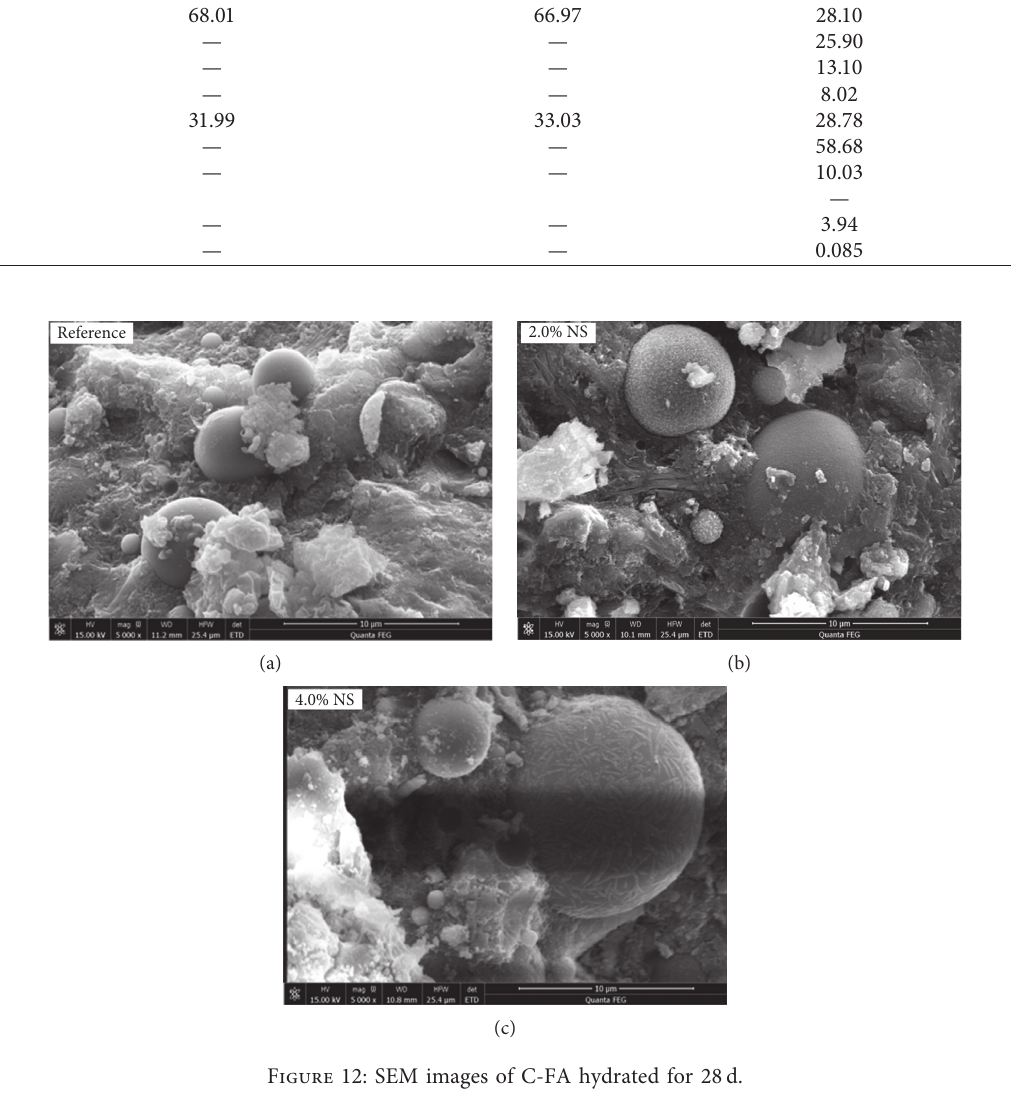
Figure 12: SEM images of C-FA hydrated for 28d.